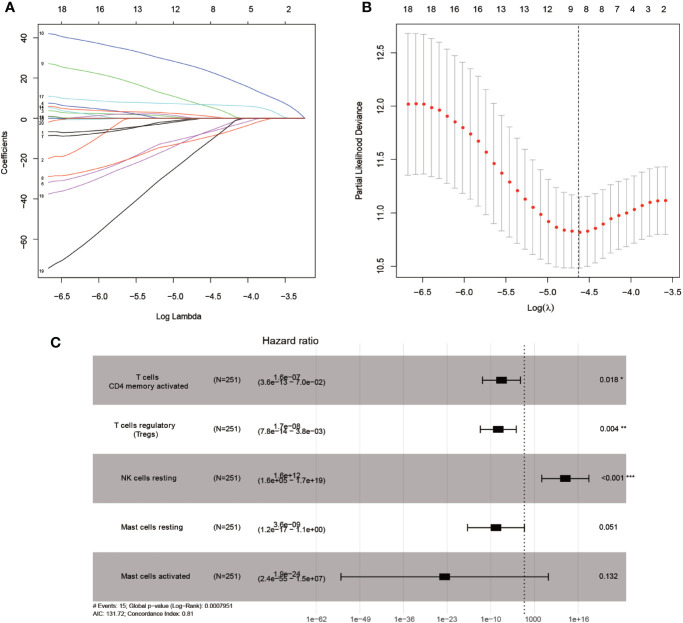
Identifying prognostic tumor-infiltrating immune cells by multivariate analysis. (A, B) LASSO regression coefficient profiles of prognostic tumor-infiltrating immune cells; (C) The forest map of multivariate the Cox regression analysis.